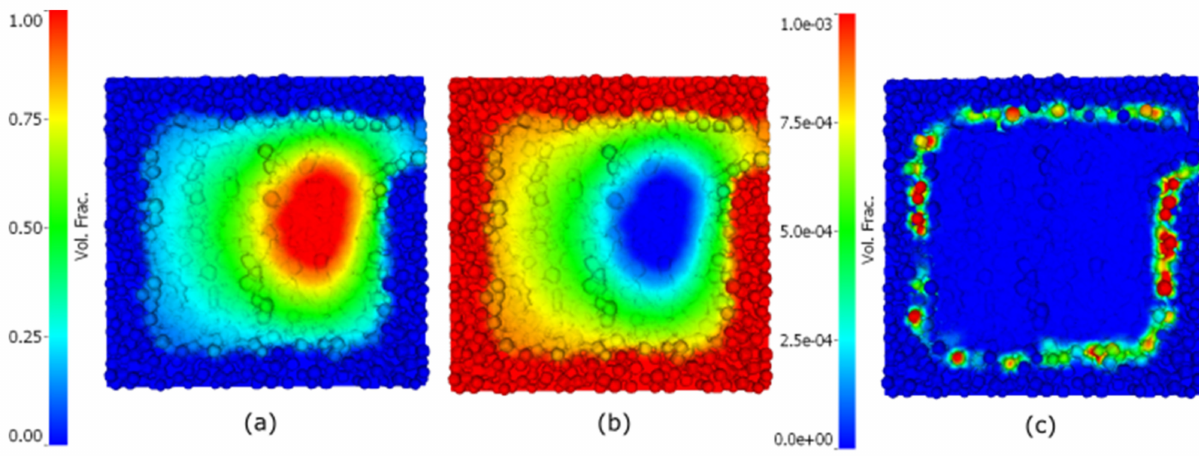
Figure 9. Volume fractions of microstructure phases of the powder bed at time t = 0.022 s ( a ) β ; ( b ) α ms ; ( c ) α wid . The grey section in the β plot denotes the melted Ti-6Al-4V